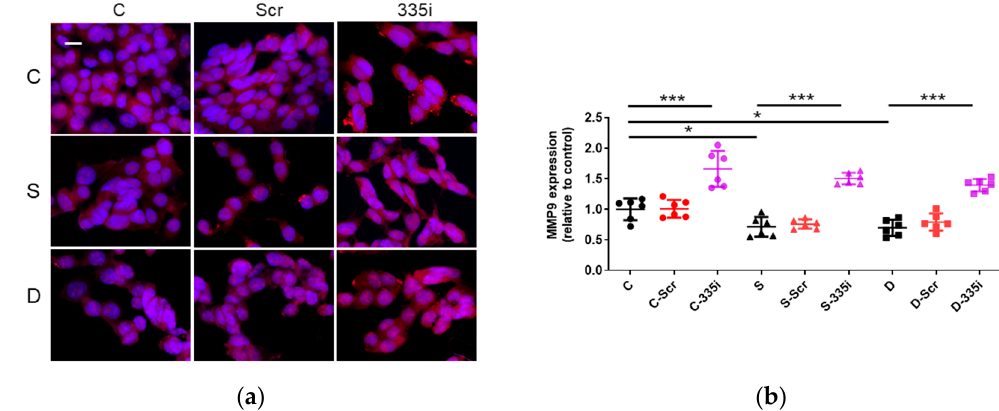
Figure 5. The MMP9 expression changes after inhalational anesthesia with miRNA inhibitor pretreatment in neuroglioma (H4) cells. ( a ) MMP9 immunofluorescence staining, MMP9 (red) in control (upper), sevoflurane- (middle) and desflurane- treated (bottom) H4 cells with miRNA inhibitor pretreatment, counterstained with DAPI (blue); ×20 magnification, scale bar = 20 μ m. ( b ) The comparison of the MMP9 immunofluorescence intensity with each anesthetic and miRNA inhibitor pretreatment. Data showed as plots and mean ± SD (n = 6). * p < 0.05, *** p < 0.001; one-way ANOVA with Tukey-Kramer compared to each control group. C: control, S: sevoflurane, D: desflurane, Scr: scrambled miRNA and 335i: miR-335 inhibitor.